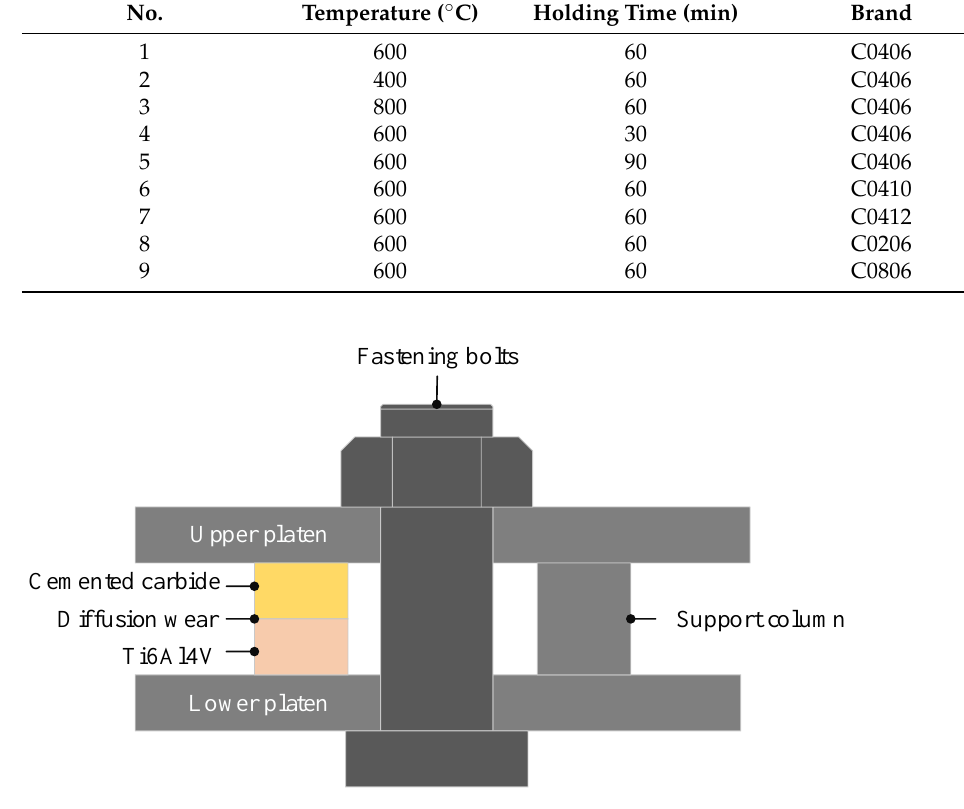
Figure 2. Schematic diagram of the element diffusion experiment.